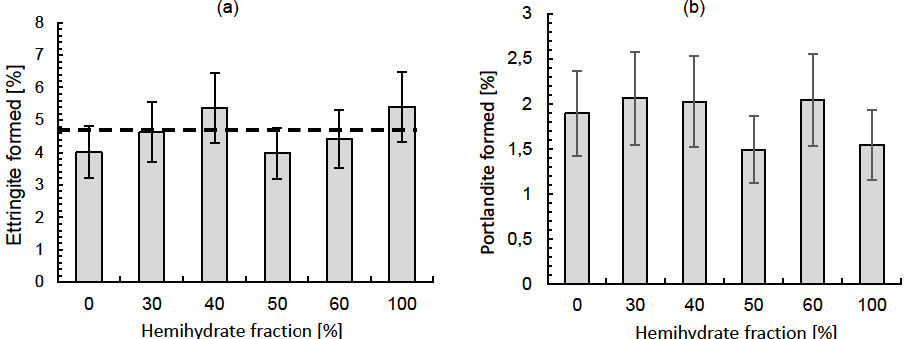
Figure 4: Amount of hydrate products precipitated after 1 hour of cement hydration with different fractions of hemihydrate within the sulfate-carriers; (a): Ettringite and (b): Portlandite. The dashed line is the average of all